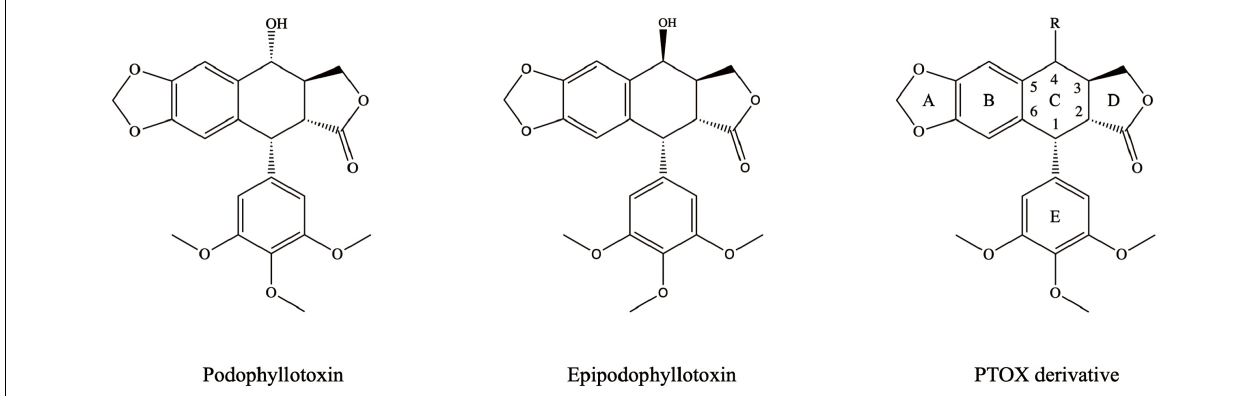
FIGURE 1 | Chemical structures of podophyllotoxin, epipodophyllotoxin, and PTOX derivative.